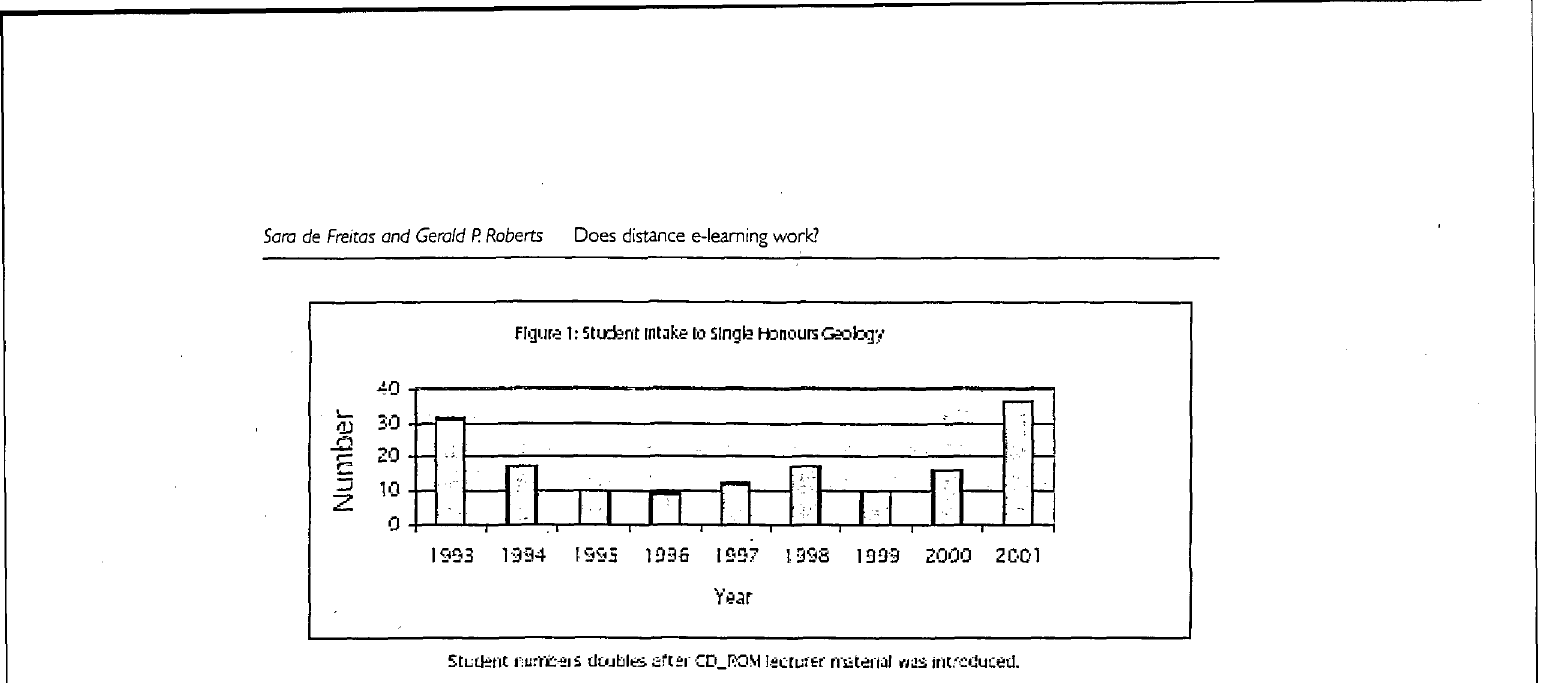
Figure 2: Percentage net taking Intio to Geology